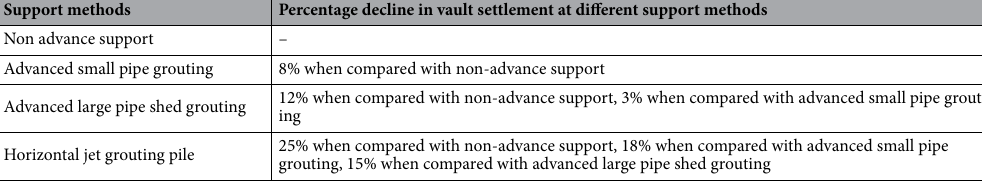
Table 9. Percentage decline in vault settlement at different support methods.